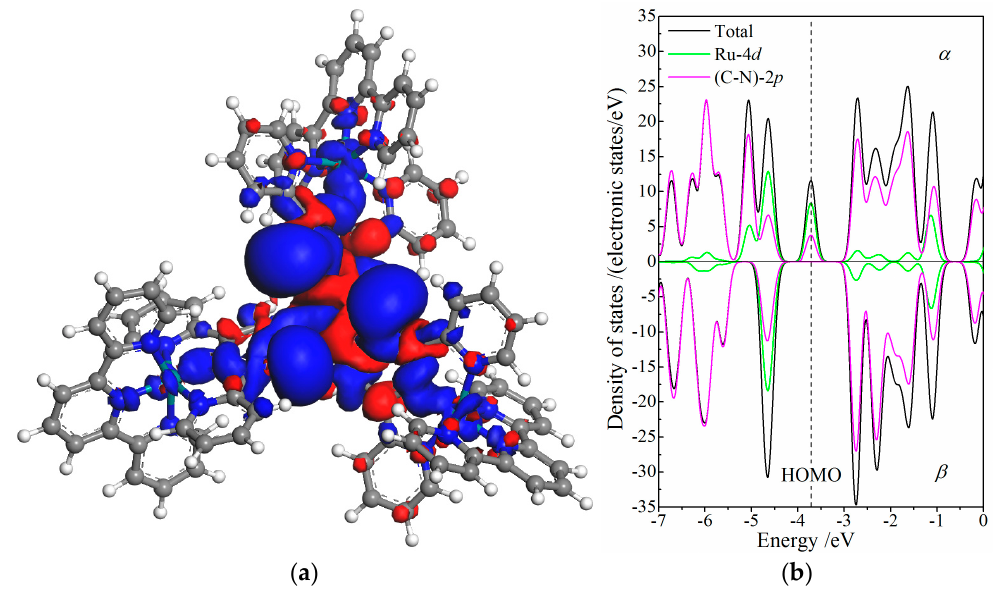
Figure 6. ( a ) Density iso-surfaces of spin electrons contoured at 0.005 electrons/Å 3 with blue and red colors indicating α and β spin states, respectively; ( b ) spin-dependent orbital-resolved PDOS of Ru-4 d and N-C-2 p orbitals with vacuum free electron level being referenced as energy zero, for +4 redox state of CTTC molecule.